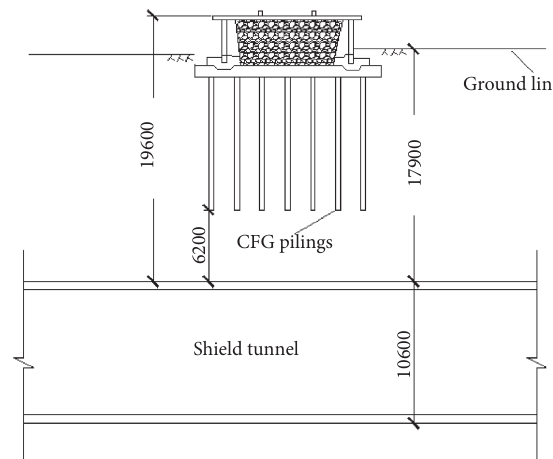
Figure 2: The vertical relationship between the shield tunnel and existing